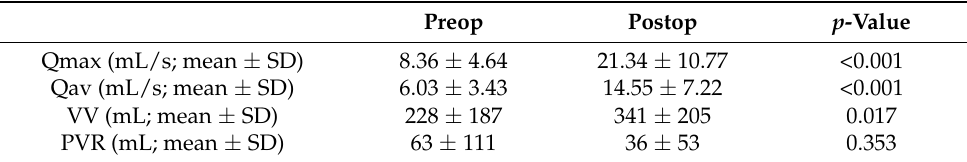
Table 3. Voiding outcomes of Asopa’s technique for meatal strictures.